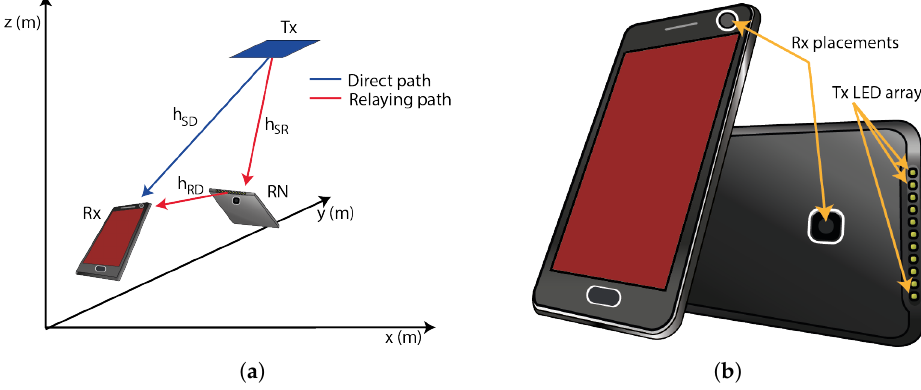
Figure 2. ( a ) Mobile user position in a room; and ( b ) the positions of the Rx and Tx on a mobile device. Table 2. Mobile Device